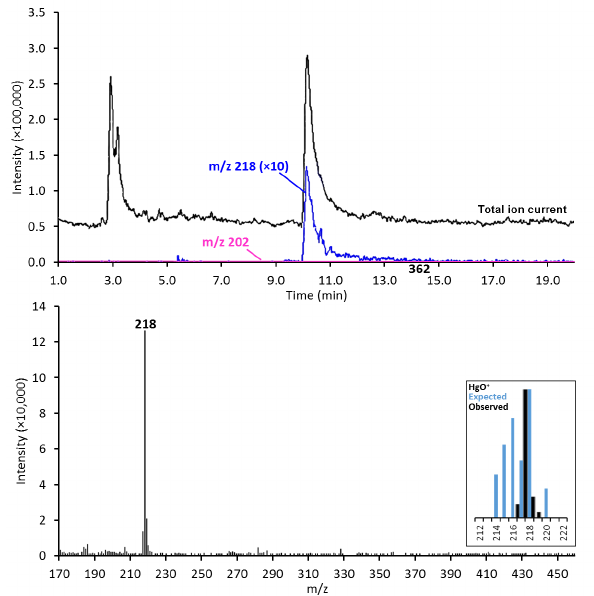
Figure 5. Chromatogram (above) and mass spectrum at 10.10min (below) generated from analysis of 34ngHg emitted from an HgO permeation tube. The box on the bottom right compares the ex- pected HgO + mass spectrum (from de Laeter et al., 2004) to the observed spectrum. While the prominent mass peak was m/z 218, the observed isotope pattern does not indicate HgO +